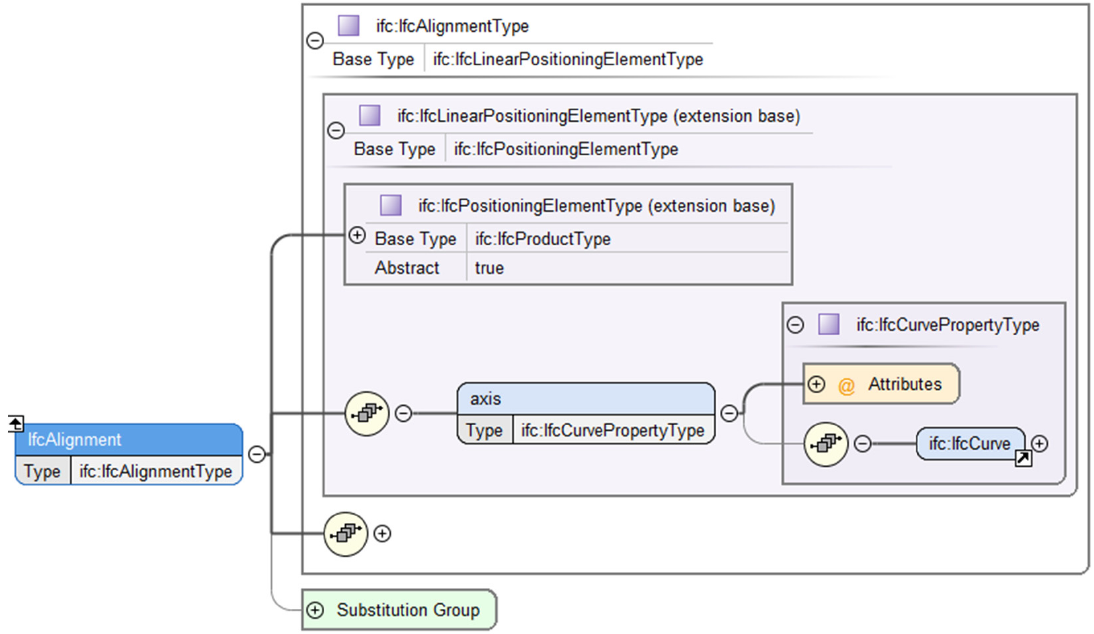
Figure 17. Extract from the IfcProductExtension GML schema, illustrated in Oxygen XML Editor [57].